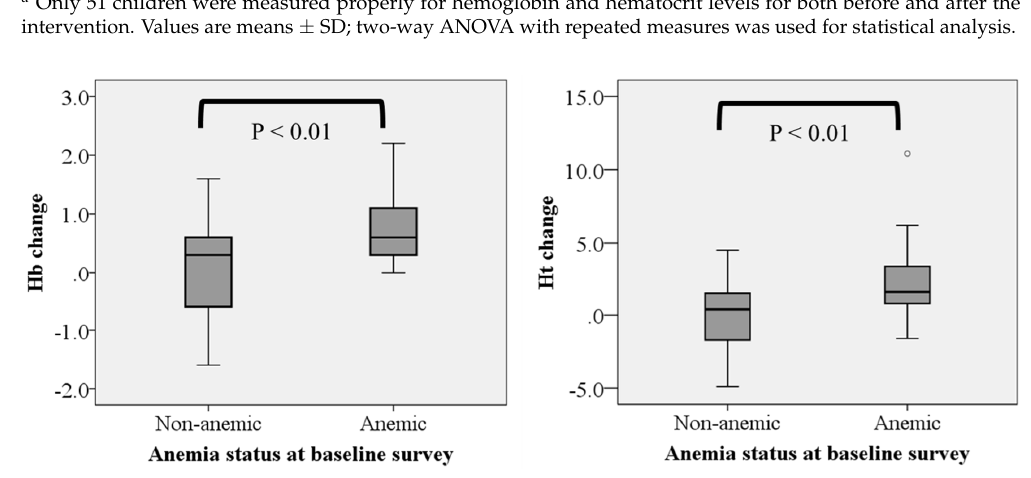
Figure 3. Comparison of changes in hemoglobin and hematocrit levels between anemic and non-anemic groups based on the status at the baseline. The boxes represent the median (black middle line) limited by the 25th (Q1) and 75th (Q3) percentiles. The whiskers are the upper and lower adjacent values, which are the most extreme values within Q3 + 1.5 (Q3 − Q1) and Q1 − 1.5 (Q3 − Q1), respectively. The dot represents an outlier.